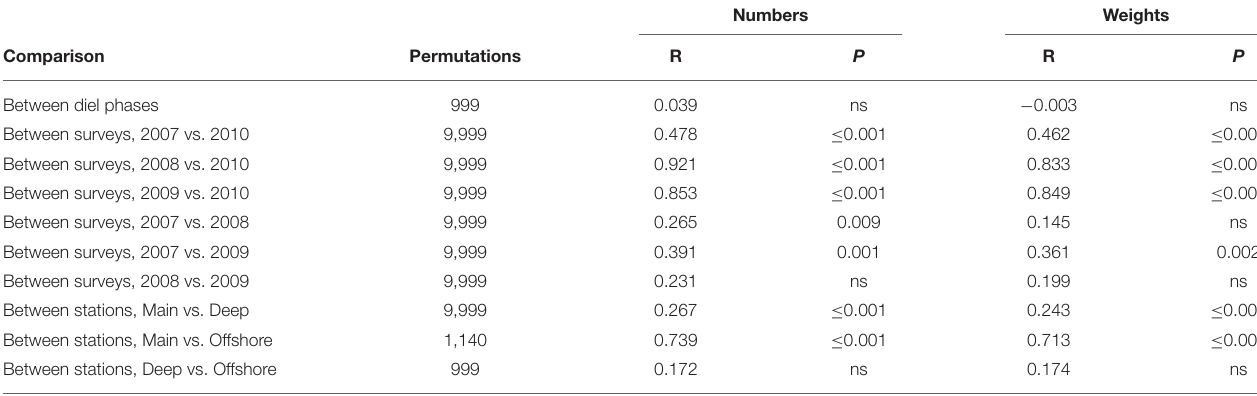
TABLE 5 | Results of pair-wise ANOSIM tests on sets made to 1,250m or deeper that returned P ≤ 0.01 and of selected tests which did